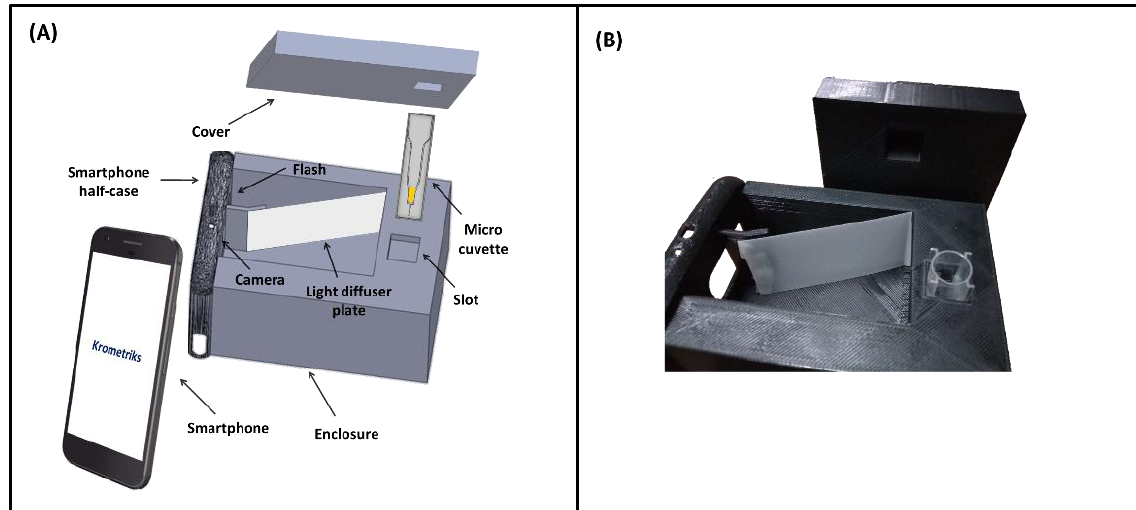
Figure 1. ( A ) 3-D schematic diagram of the Krometriks system and its components. The smartphone’s camera and flashlight act as the sensing detector and light source, respectively. ( B ) Picture of the 3-D printed Krometriks